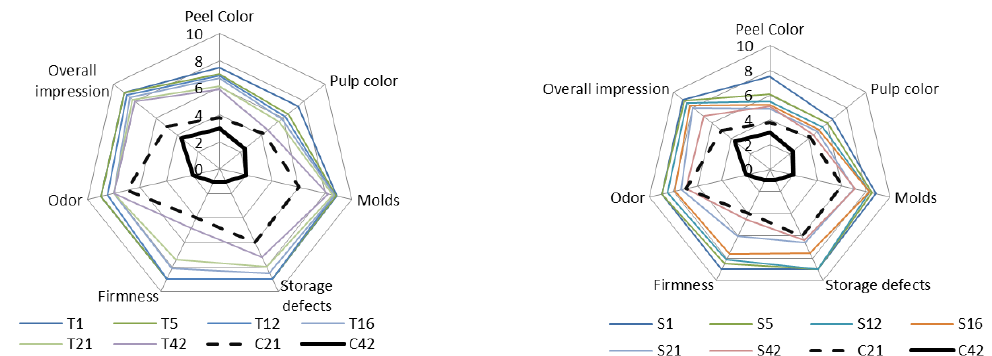
Figure 9. Influence of the coating on zucchini sensory evaluation after 42 days of storage. T1, T5, T12, T16, T21, and T42 represent the average score for each individual sensory attribute obtained by the coated zucchini with Tween 20 stabilizer in the 1st, 5th, 12th, 16th, and 42nd day of storage, respectively; S1, S5, S12, S16, S21, S42 represent the average score for each individual sensory attribute obtained by the coated zucchini with gums mixture as a stabilizer in the 1st, 5th, 12, 16th, and 42nd day of storage, respectively; C21 and C42 represent the average score for each individual sensory attribute obtained for uncoated zucchini (control) in the 21st and 42nd day, respectively.